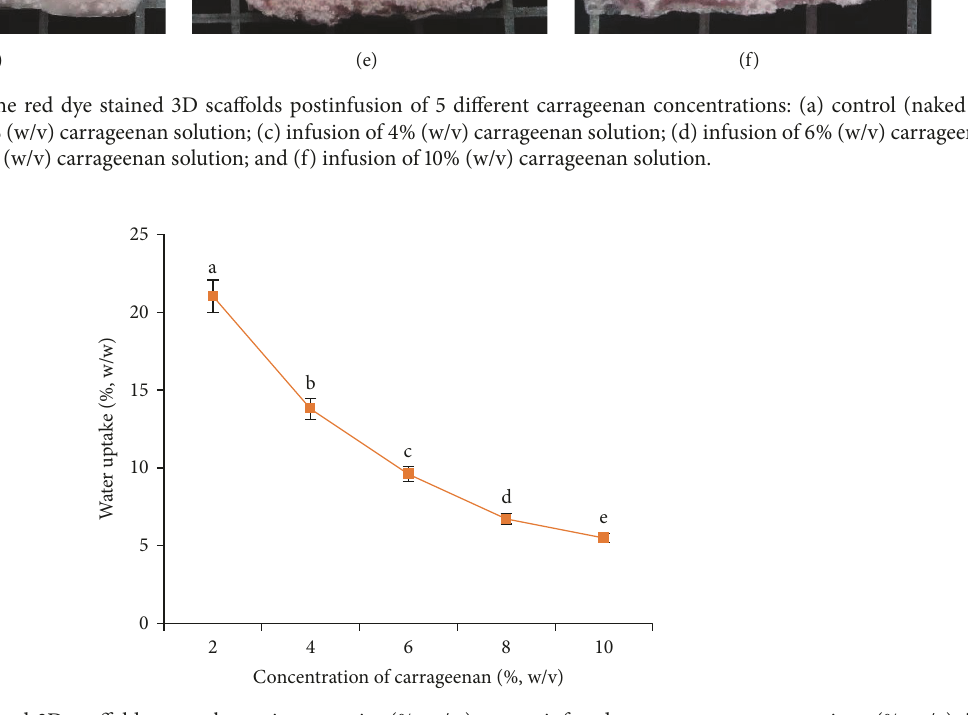
Figure 5: Inversely correlated 3D scaffold water absorption capacity (%, w/w) versus infused carrageenan concentrations (%, w/v). The experiments were carried out in triplicate ( 𝑛 = 3 ). Different alphabet shows significant difference ( 𝑝 < 0.05 ) between